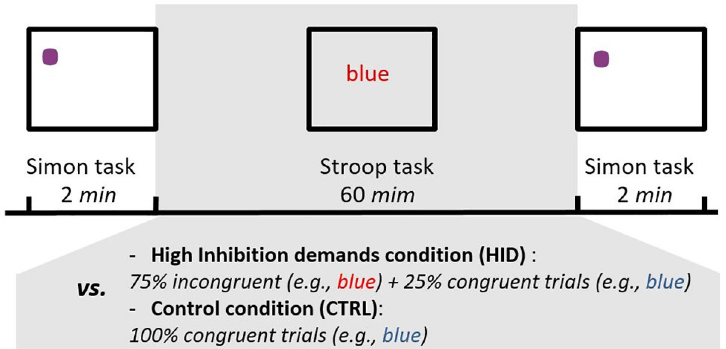
Fig 1. Illustration of the protocol used in Study 1 and Study 2. Note that Study 1 used a between-subjects design to manipulate the inhibition demands required in the Stroop task whereas Study 2 used a within-subjects design to manipulate inhibition